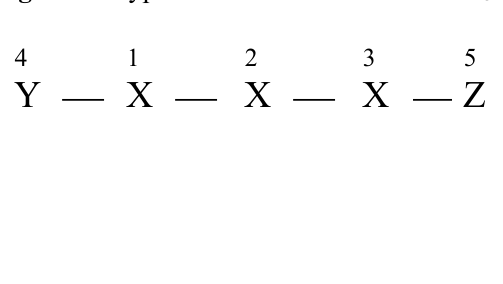
Figure 1. Hypothetical linear molecule YX